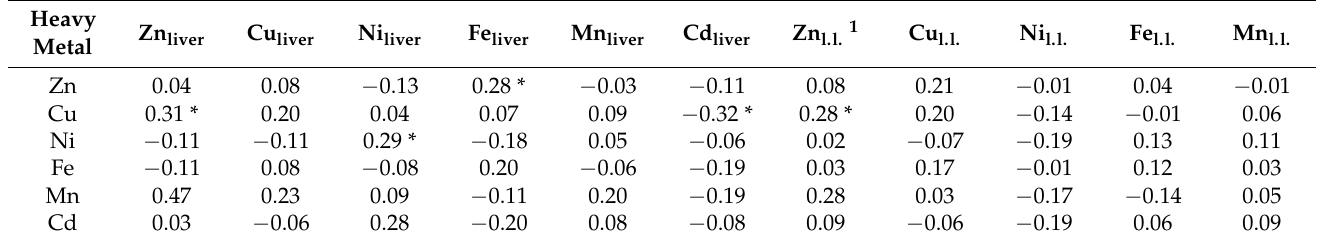
Table 6. The phenotypic correlation coefficients among metals in the nettle and liver and rabbit meat.